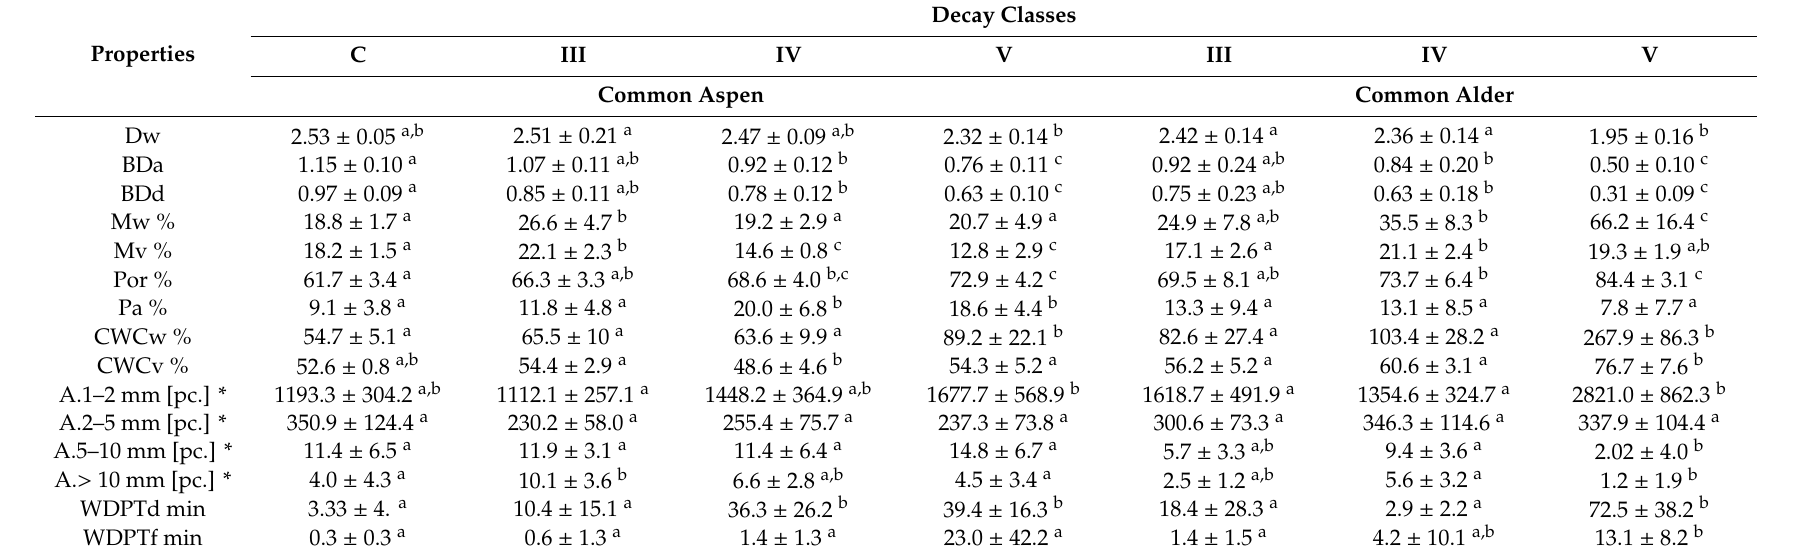
Table 5. Physical properties of soil collected under deadwood and from the